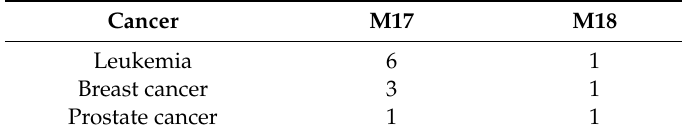
Table 6. The number of overlapping KEGG pathways enriched by first-order genes of M17 and M18 and disease-causing genes for leukemia, breast cancer, and prostate